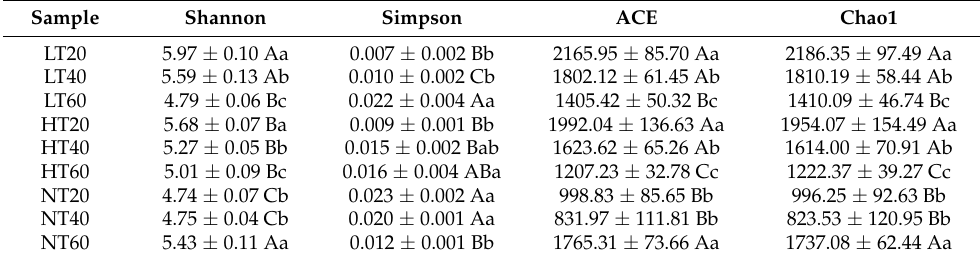
Table 2. Soil bacterial alpha diversity indices.